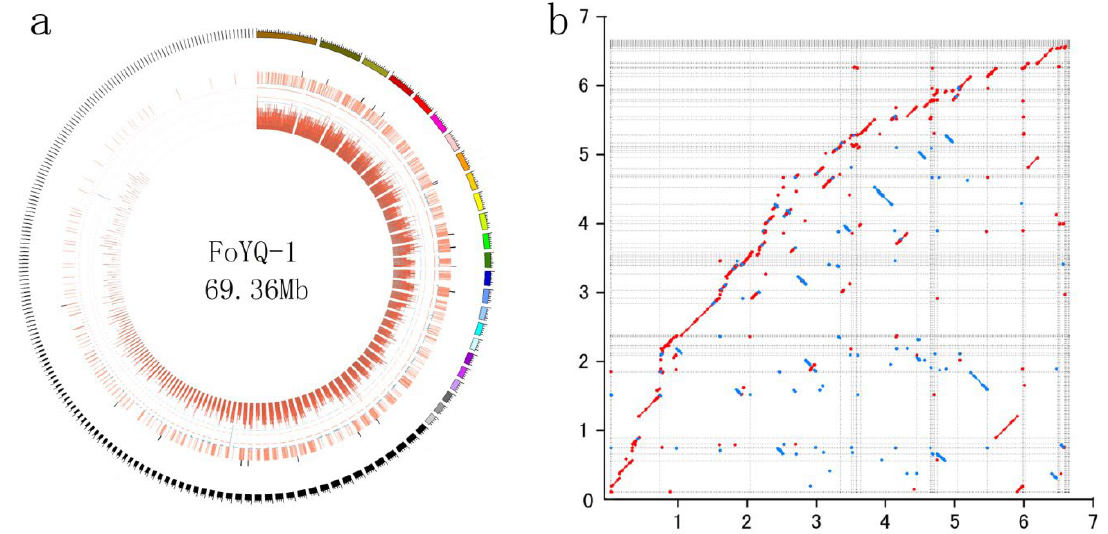
Figure 2. Genome feature of FoYQ-1 and the syntenic relationships with the published chromosome-level FOC genome GCA_014839635.1 ( a ) Genome feature of FoYQ-1. The outermost circle is the contigs. The bar chart from outside to inside in turn is secondary metabolites gene clusters (black), secreted proteins (orange), density of repetitive sequence (blue), and gene density (dark red); ( b ) the syntenic relationships between two genomes. Y-axis represents FoYQ-1 contigs, and x-axis represents GCA_014839635.1 chromosomes. The axis tick values represent genome size ( × 10 Mb). The red dot or line represents forward matches, and the blue dot or line represents reverse matches between two genomes.